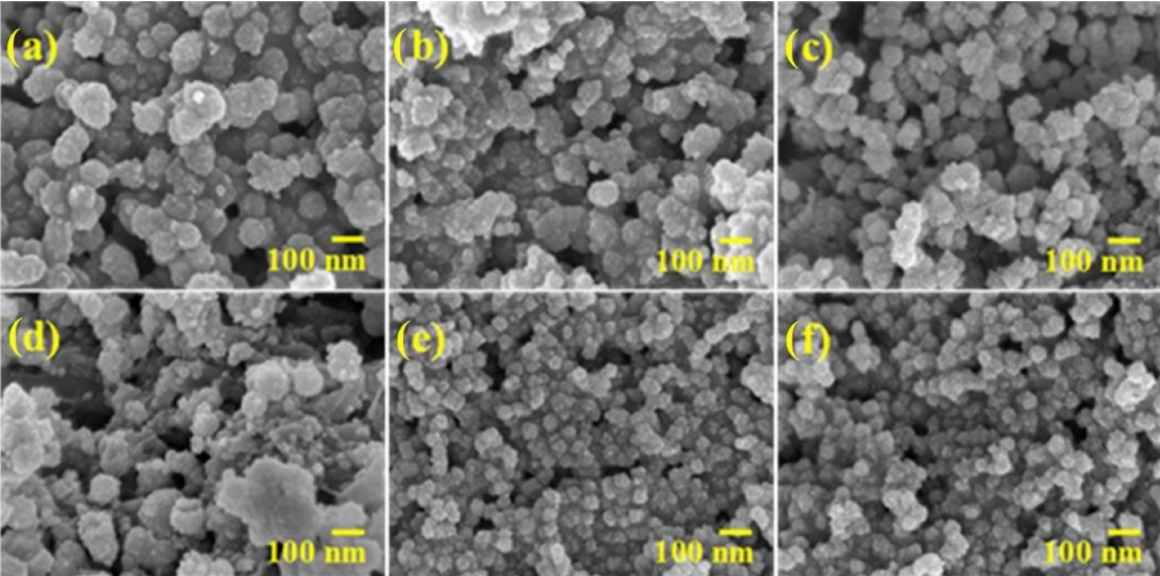
Figure 1. FE-SEM images of ZnS/COF composite photocatalyst with different COF ratios: ( a ) ZnS, ( b ) ZnS/0.5COF, ( c ) ZnS/1COF, ( d ) ZnS/2COF, ( e ) ZnS/4COF, ( f ) ZnS/5COF.